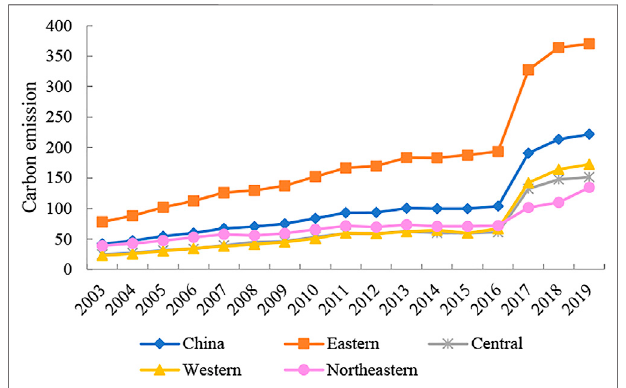
FIGURE 2 | Changing trends of carbon emission in China and four